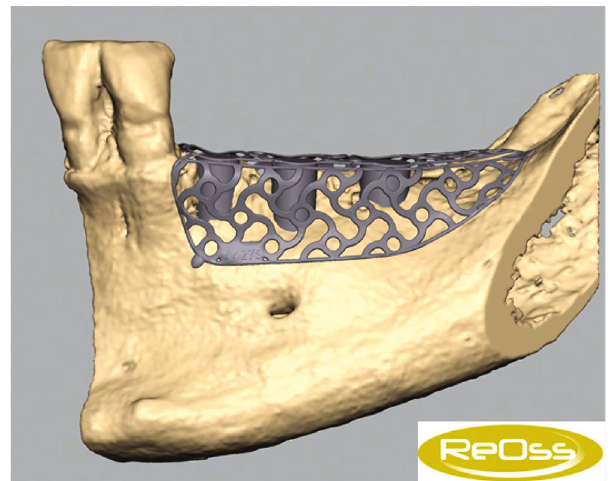
Figure 8: Muco-periosteal fl ap in the 4th